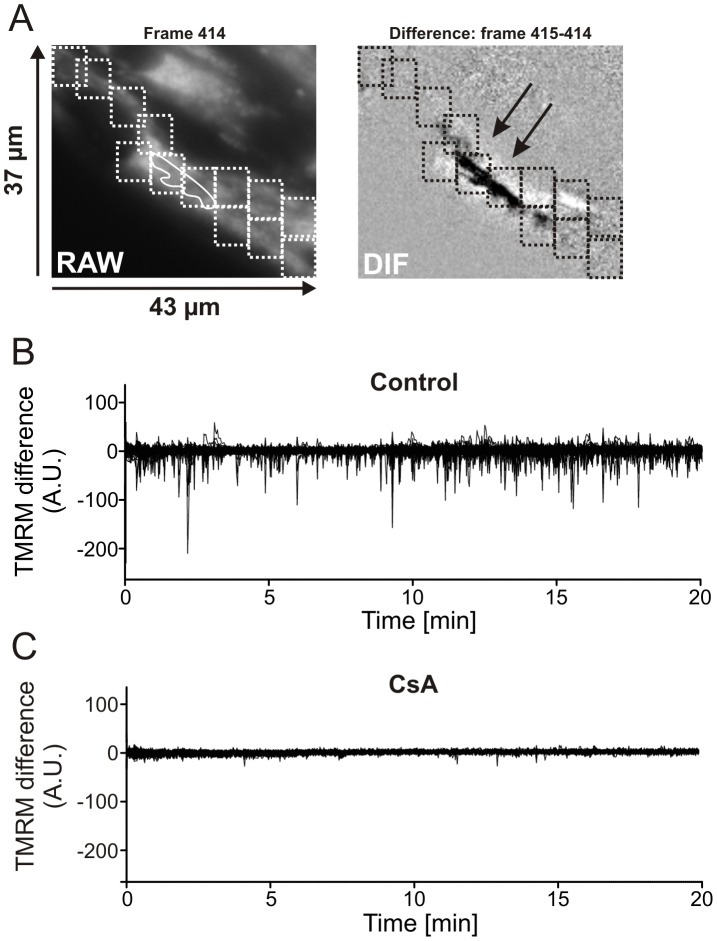
Manual analysis of ΔΨ flickering temporal properties.(A) A typical example of the position of identical rectangular regions of interest (ROIs; dotted rectangles) along the myotube in the raw frame (left panel) and DIF frame (right panel). The two black arrows indicate two ROIs detecting the same depolarization. (B) Variation of signal intensity in the DIF frames of ∼110 ROIs in one cell during 20 minutes. (C) Similar to panel B but now for ∼100 ROIs in 2 myotubes treated with the mitochondrial permeability transition pore inhibitor cyclosporine A (CsA; 5 µM, 2 h).